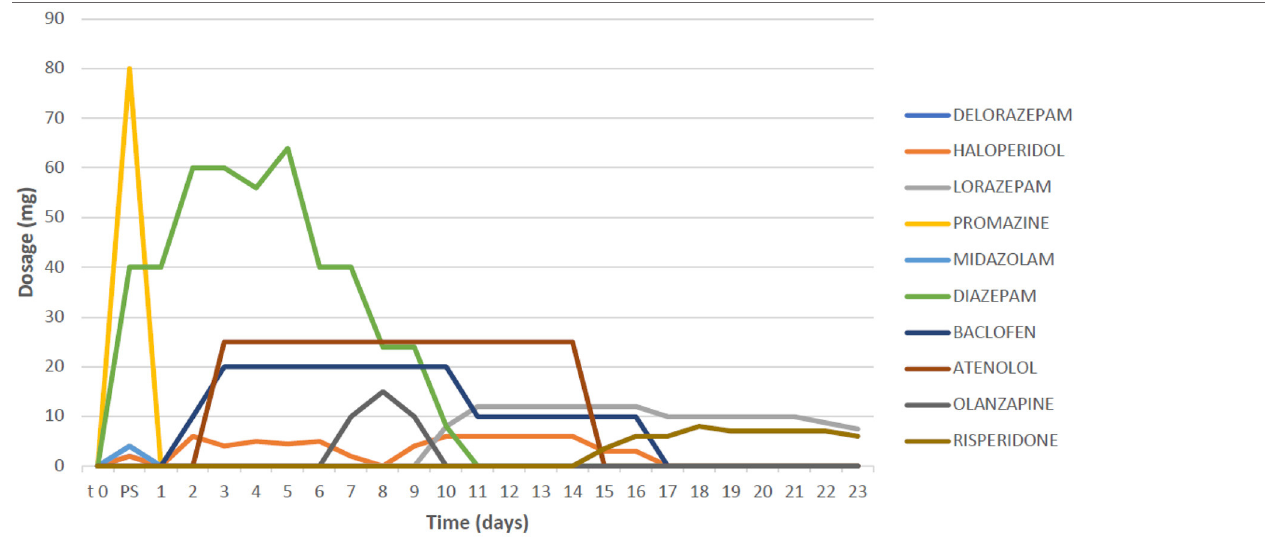
TABLE 2 | Timeline regarding drug treatment and